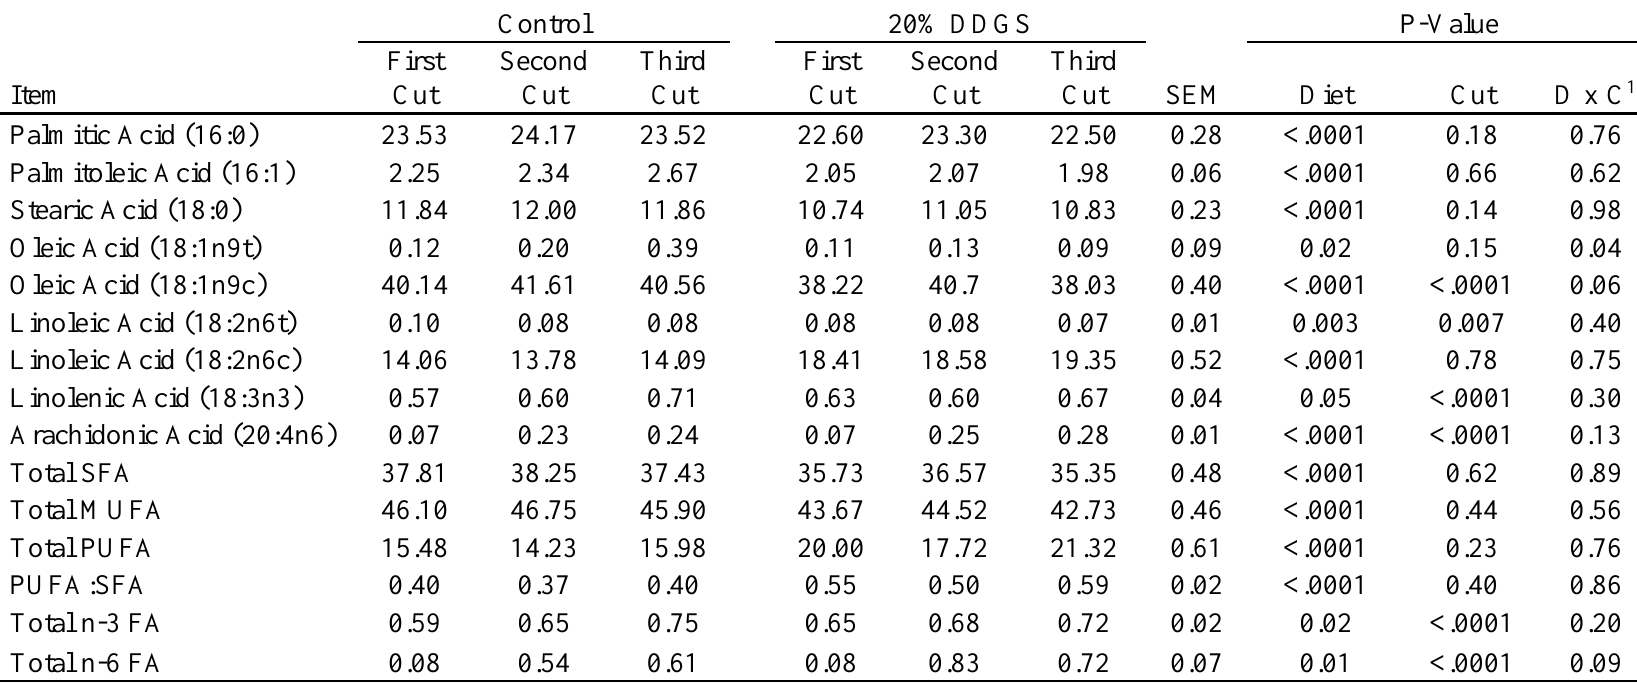
Table 4. Interactive effects of 20% DDGS in the diet and marketing time on fatty acid (FA) composition of belly fat Control 20% DDGS